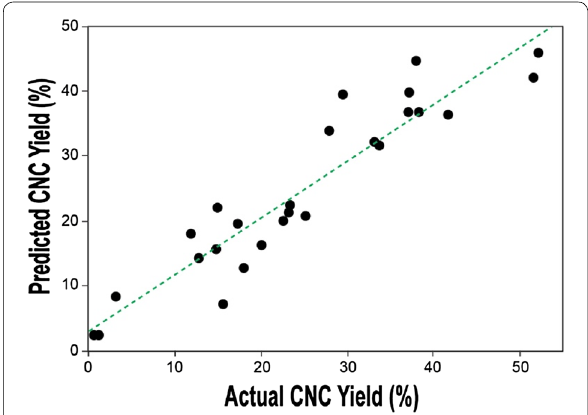
Fig. 2 Experimental vs predicted yields in the regression